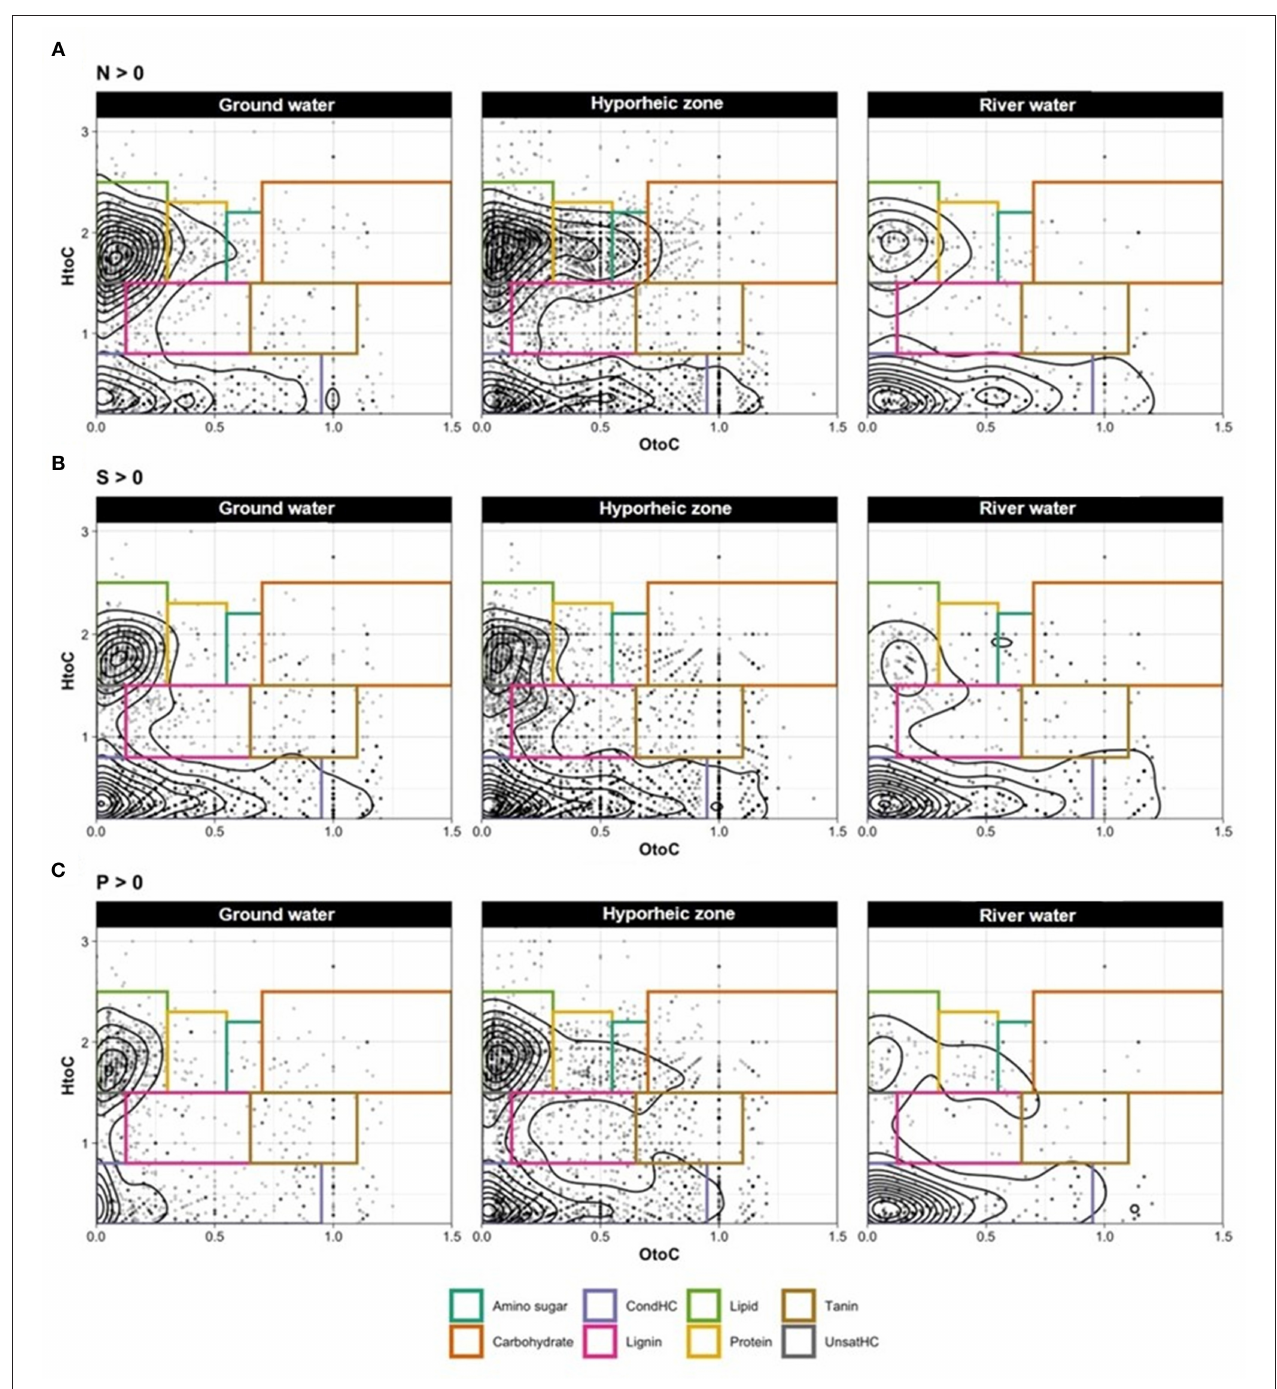
FIGURE 3 | Van Krevelen (VK) diagrams (with contoured lines) for compounds containing only (A) nitrogen (N), (B) sulfur (S), and (C) phosphorus (P) in the samples ground water (left panel), hyporheic zone (middle panel), and river water (right panel).